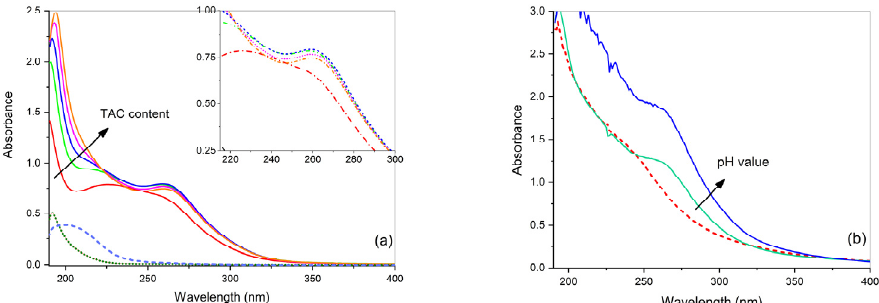
Figure 3. ( a ) UV-Vis absorbance spectra of free aqueous solutions containing CuSO 4 and ammonium citrate tribasic (TAC) at increasing M:L molar ratios (1:1, 1:2, 1:3, 1:4, and 1:5); the spectra of solutions of TAC (dotted curve) and CuSO 4 (dashed curve) are also reported for comparison. ( b ) UV-Vis absorbance spectra of agar gels containing CuSO 4 and TAC in molar ratio 1:2 at increasing pH (5.5 and 10.0); the spectrum of agar gel containing only CuSO 4 is also reported for comparison (dashed curve). Gel samples are 1 mm thick and the optical path for solutions in the cuvette is 1 cm.